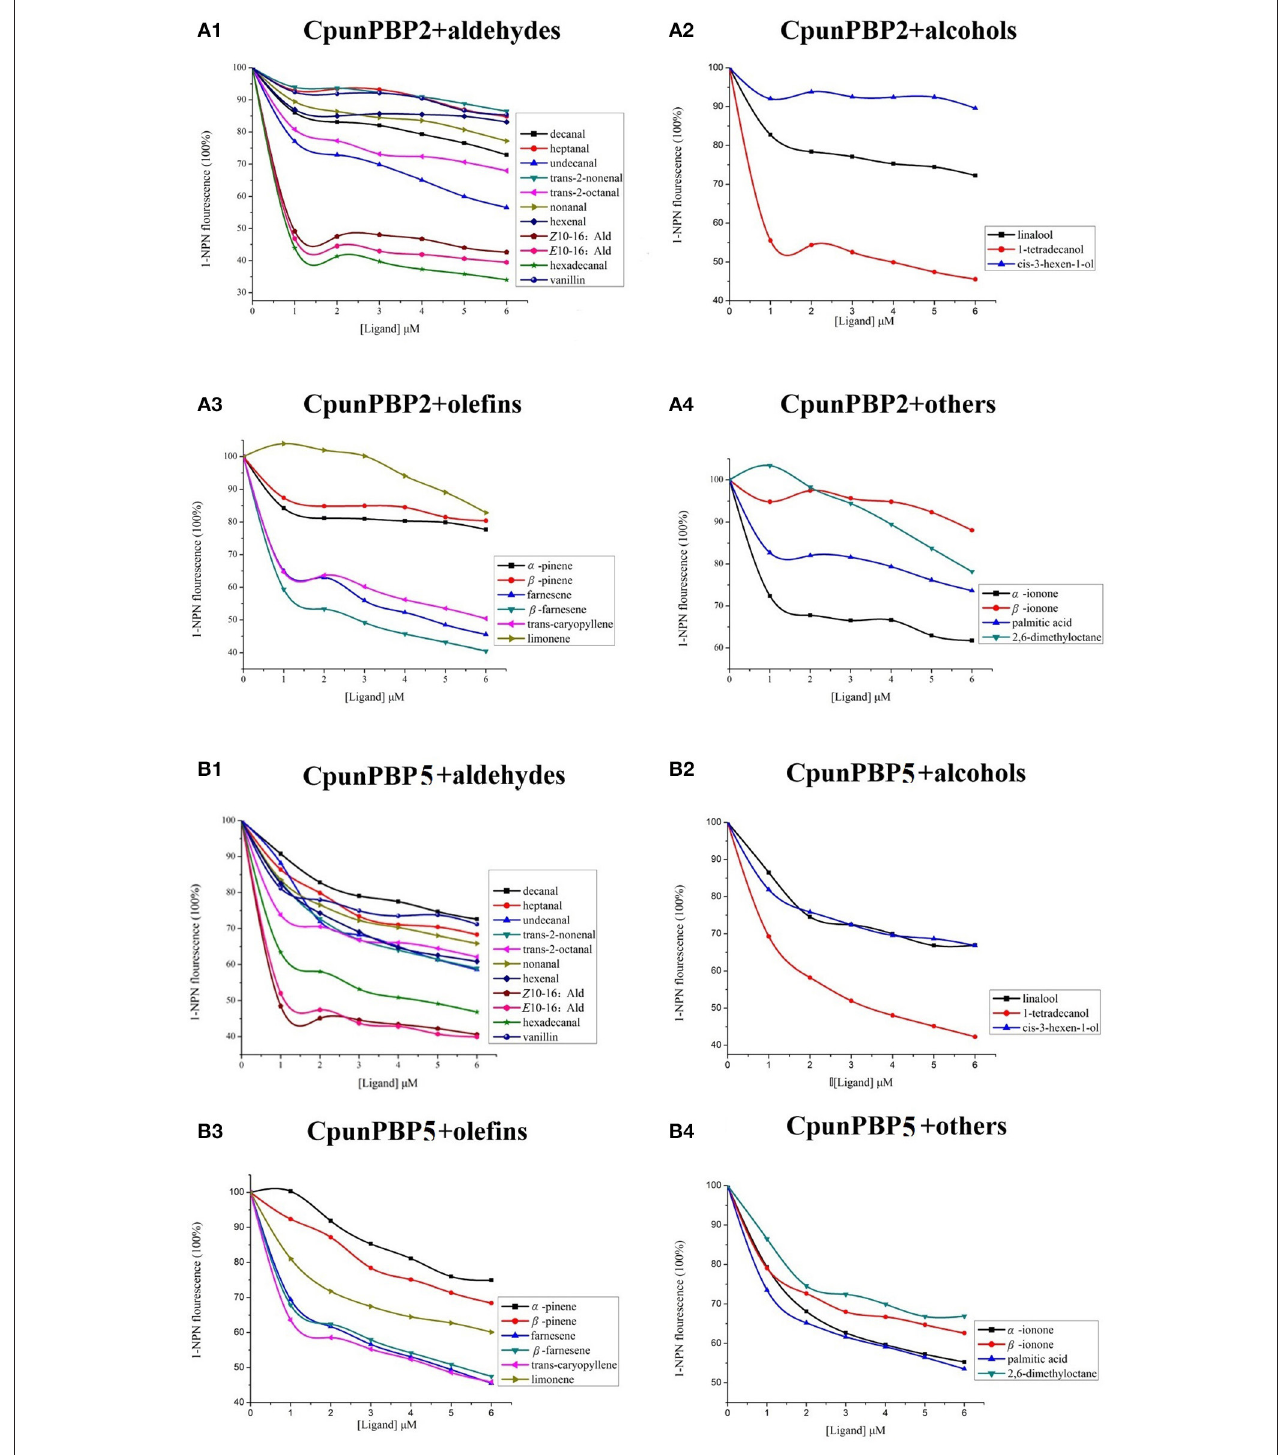
FIGURE 3 | Competitive binding curves of CpunPBP2 and CpunPBP5 to different ligands. (A1) Competitive binding curves of CpunPBP2 to aldehydes. (A2) Competitive binding curves of CpunPBP2 to alcohols. (A3) Competitive binding curves of CpunPBP2 to olefins. (A4) Competitive binding curves of CpunPBP2 to other compounds. (B1) Competitive binding curves of CpunPBP5 to aldehydes. (B2) Competitive binding curves of CpunPBP5 to alcohols. (B3) Competitive binding curves of CpunPBP5 to olefins. (B4) Competitive binding curves of CpunPBP5 to other compounds.